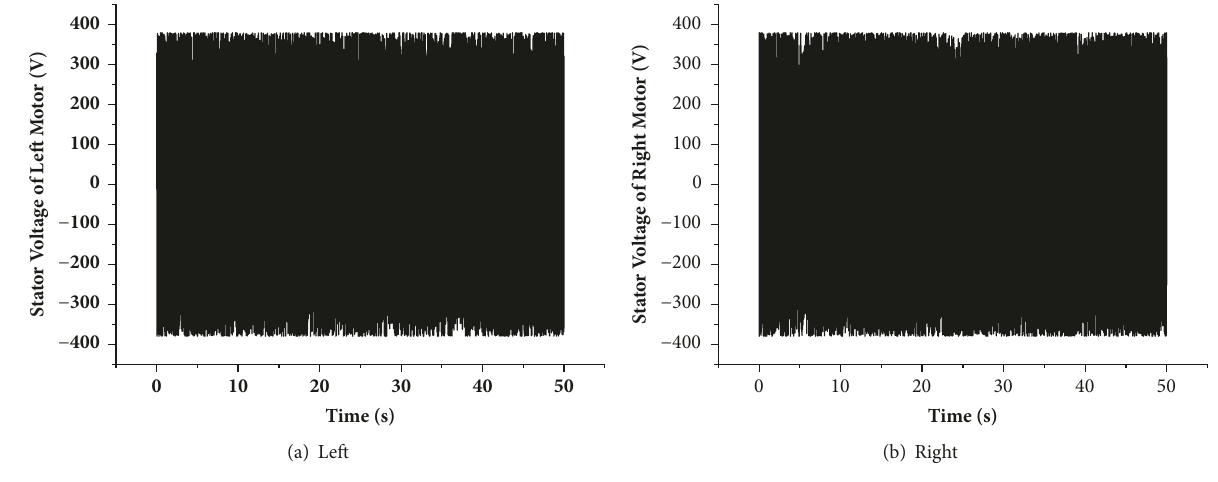
Figure 15: Single-phase voltage analysis of crawler